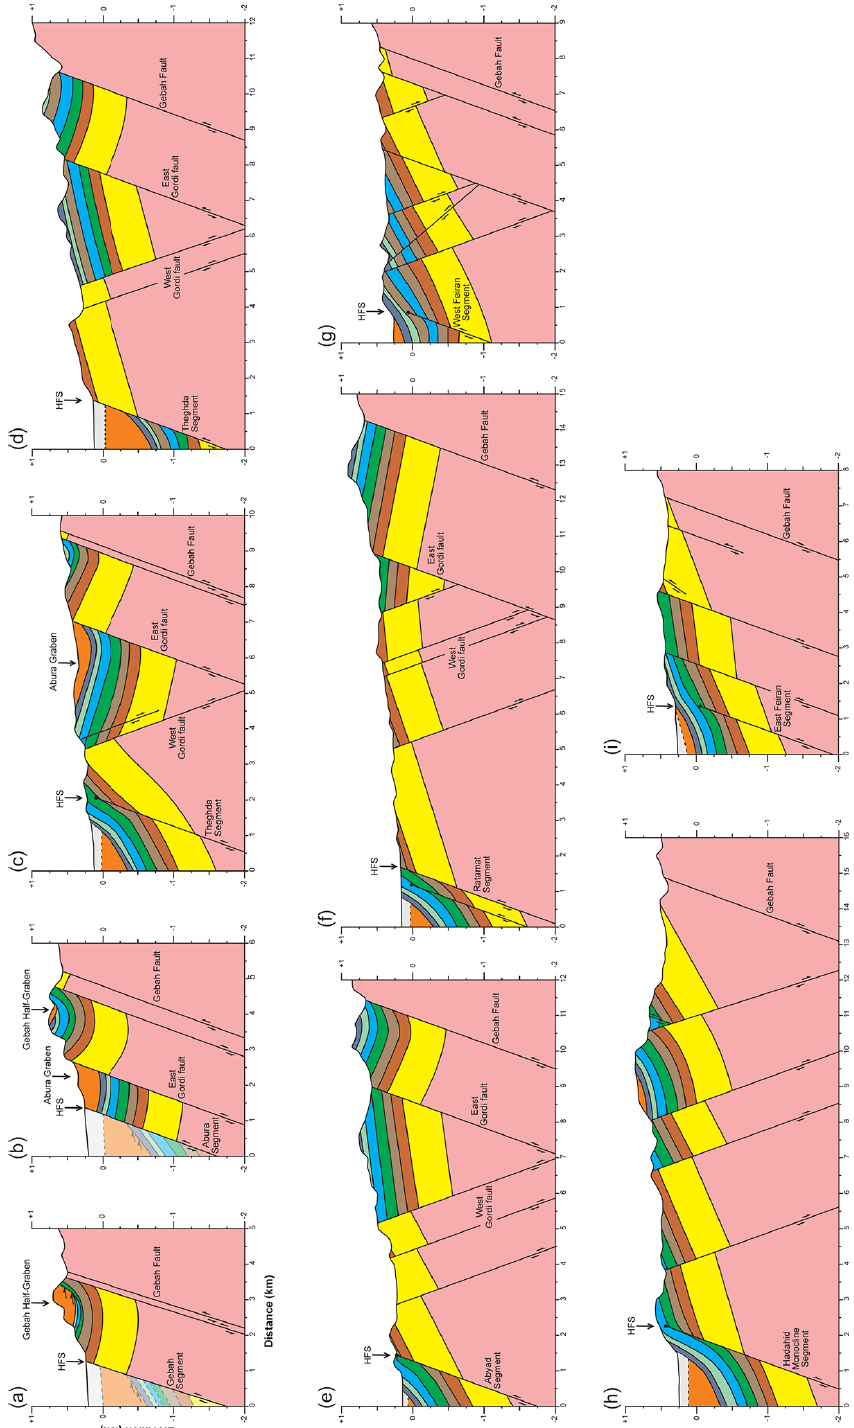
Figure 4. Cross sections through the Hadahid Fault Block from south to north, based on the mapping of Moustafa and El-Raey (1993) and Sharp et al. (2000) and mapping undertaken as part of this study. Locations of the cross sections are shown in Fig. 3a. Vertical exaggeration: 2. Colour key to stratigraphic units is shown in Fig. 3a. The mapped and inferred location of the Hadahid Fault System is shown (see text for full discussion). Note that all topographic profiles shown here and in other figures are constructed using 30m ASTM DEM data (vertical exaggeration: × 2). The geometry of the hangingwall of the Hadahid Fault System, especially on the southern segments, is largely unconstrained due to burial; it is inferred based on the measured thickness of the pre-rift succession (Fig. 3) and geometries predicted by physical and numerical models and observed in natural examples of extensional growth folds (Fig.